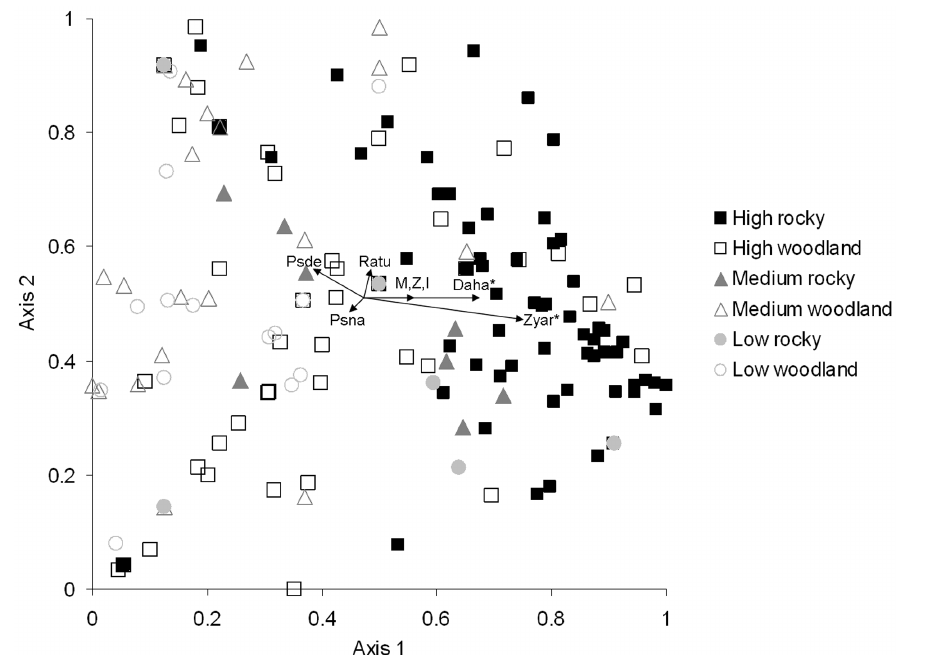
Figure 4. Bray-Curtis ordination of mammal survey data from across rainfall zones and major habitat types in the Kimberley, northern Australia, from 1994 to 2011. In the legend, ‘‘High’’, ‘‘Medium’’ and ‘‘Low’’ refer to rainfall zones (high . 800 mm, medium 600– 800 mm, low , 600 mm), and rocky and non-rocky refer to the two major savanna habitat types among survey sites. Vector lines refer to all Pearson correlations of r . 0.05, with significant correlations ( P , 0.05) denoted by ‘*’. Letter codes shown on the ordination refer to species names that correlate with ordination axes: ‘Daha’ = Dasyurus hallucatus ; ‘Zyar’ = Zyzomys argurus ; ‘Psde’ = Pseudomys delicatulus ; ‘Psna’ = Pseudomys nanus ; ‘Ratu’ = Rattus tunneyi ; and ‘M,Z,I’ = Mesembriomys macrurus, Zyzomys woodwardi and Isoodon auratus , respectively.